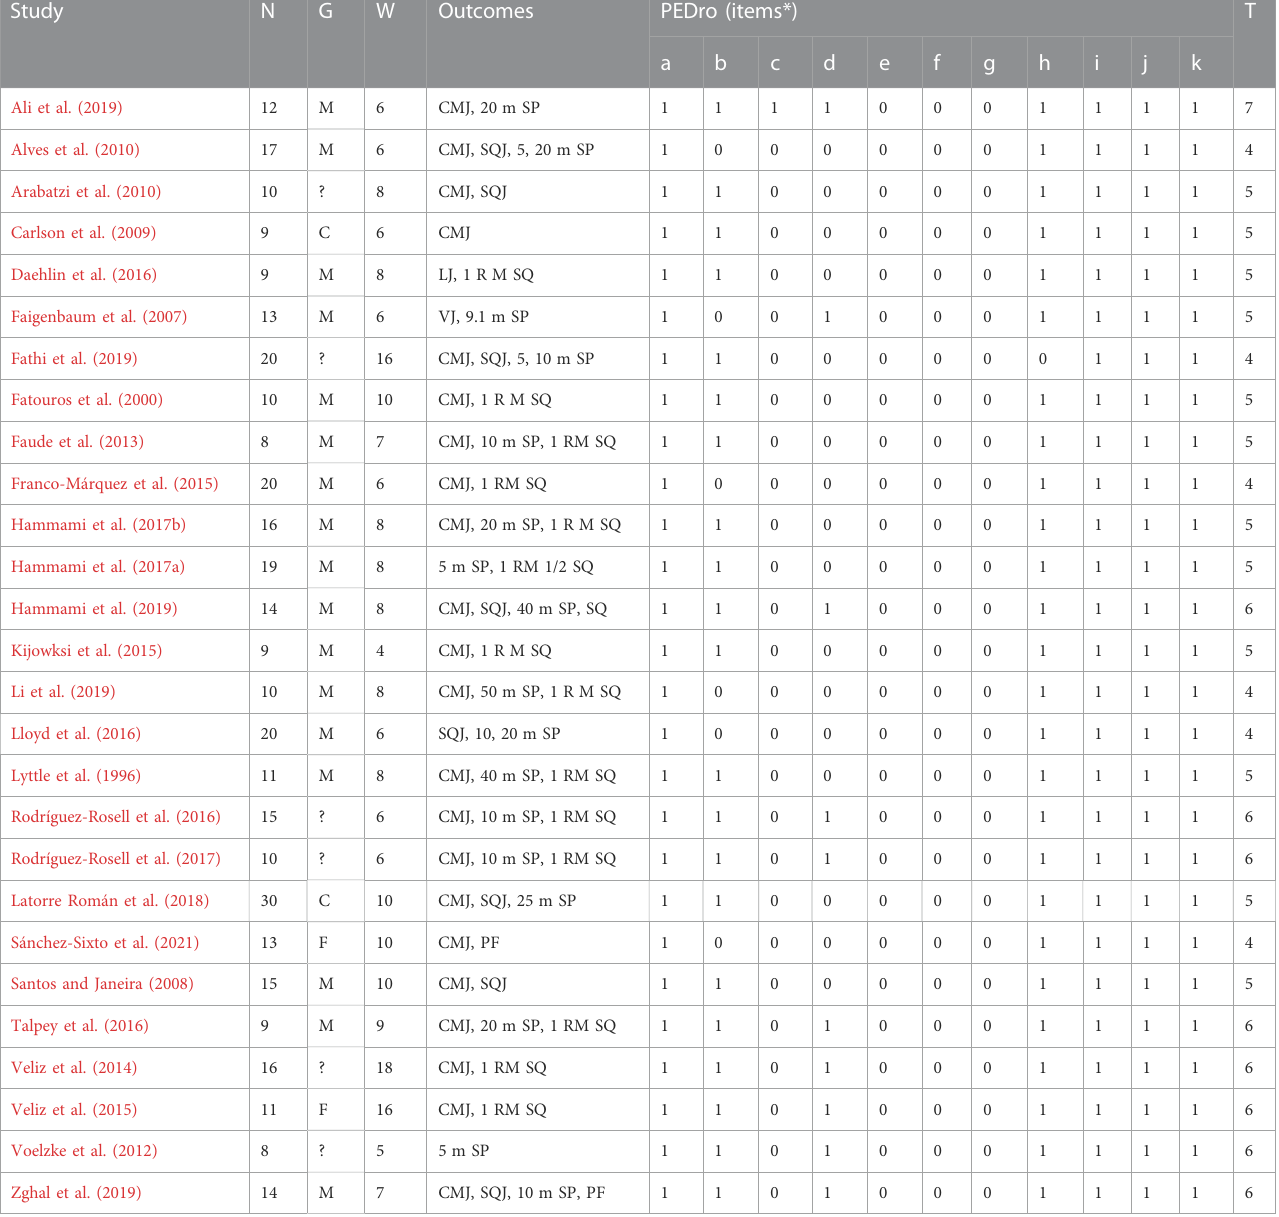
TABLE 2 Characteristics of analyzed CT studies and PEDro scores.